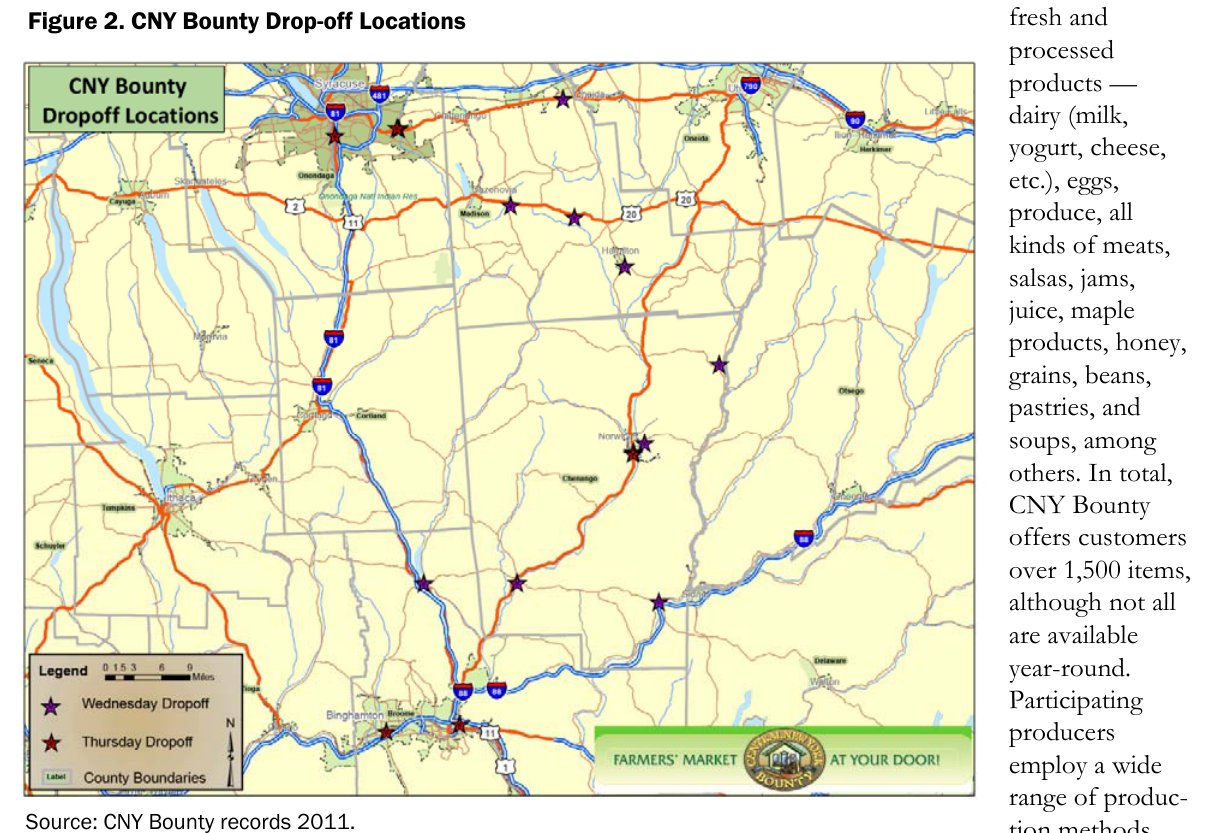
Source: CNY Bounty records